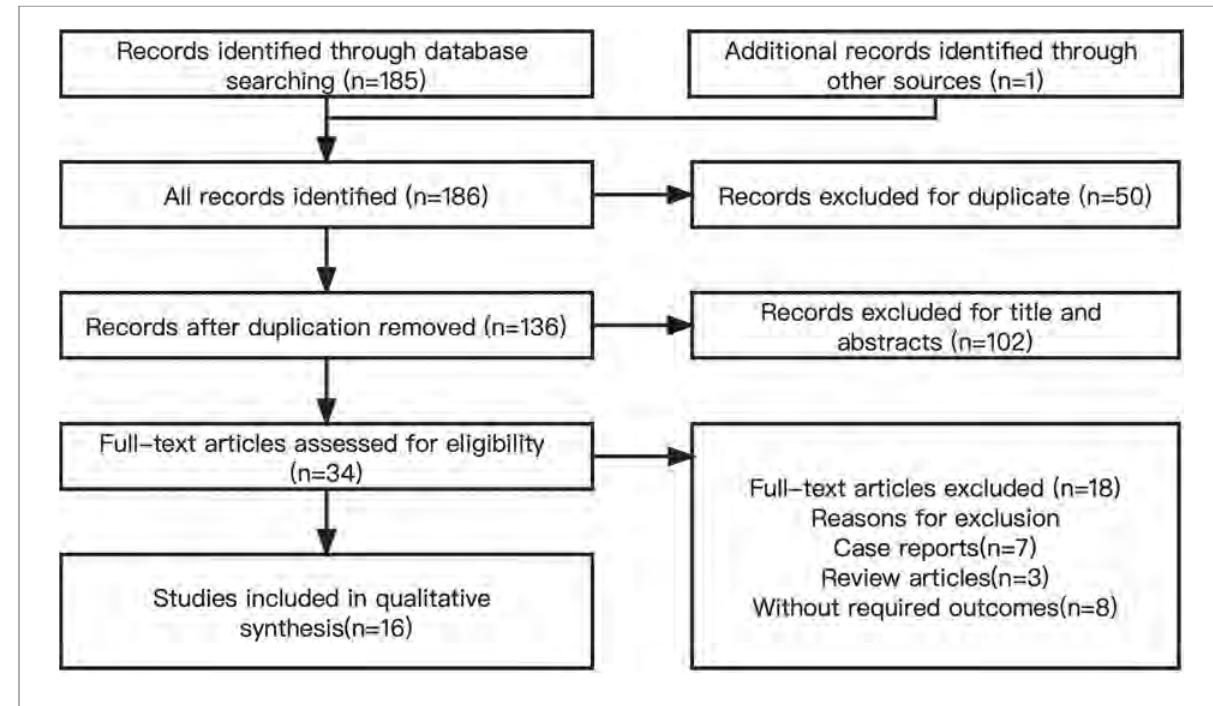
FIGURE 2 The study selection